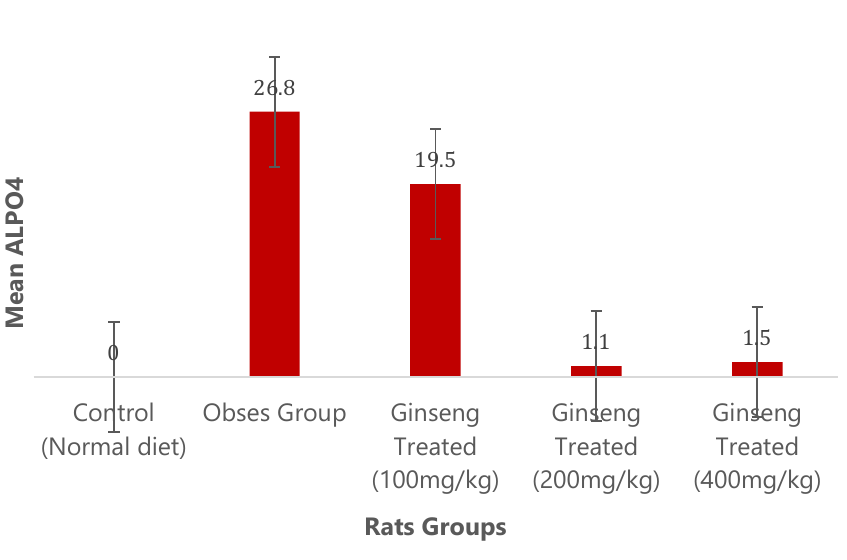
Figure 14: Comparison of mean alkaline phosphates in different